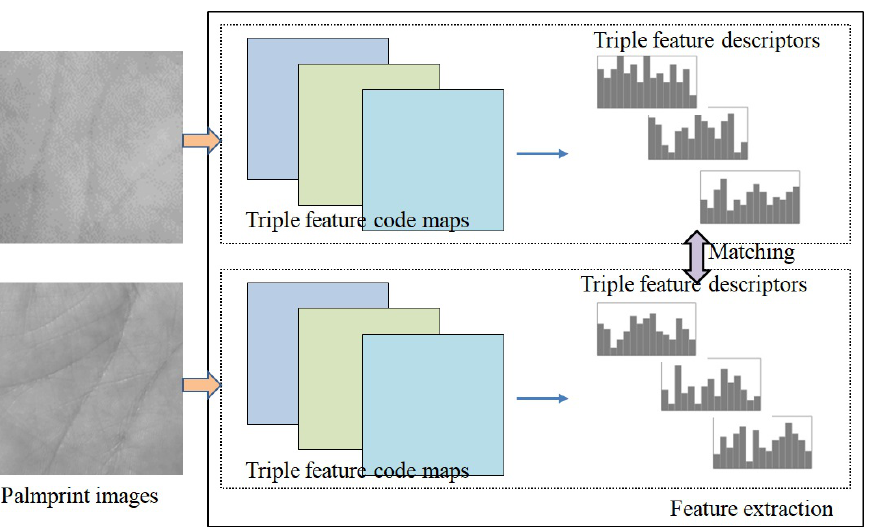
Figure 1. The basic idea of our proposed TFD method for palmprint recognition. We first extract and encode the triples types of features of a palmprint image, including the texture, gradient and direction features. Then, we form histogram-based feature vectors as the palmprint feature descriptors. Finally, we employ the weighted matching score fusion for feature matching and